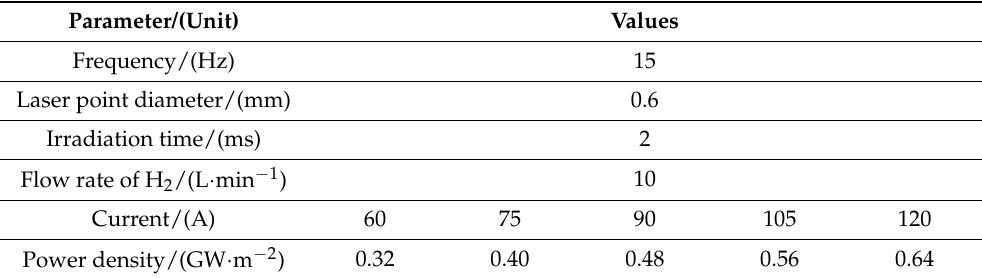
Table 1. The parameters of laser thermal shock experiment. Parameter/(Unit) Values Frequency/(Hz) 15 Laser point diameter/(mm)